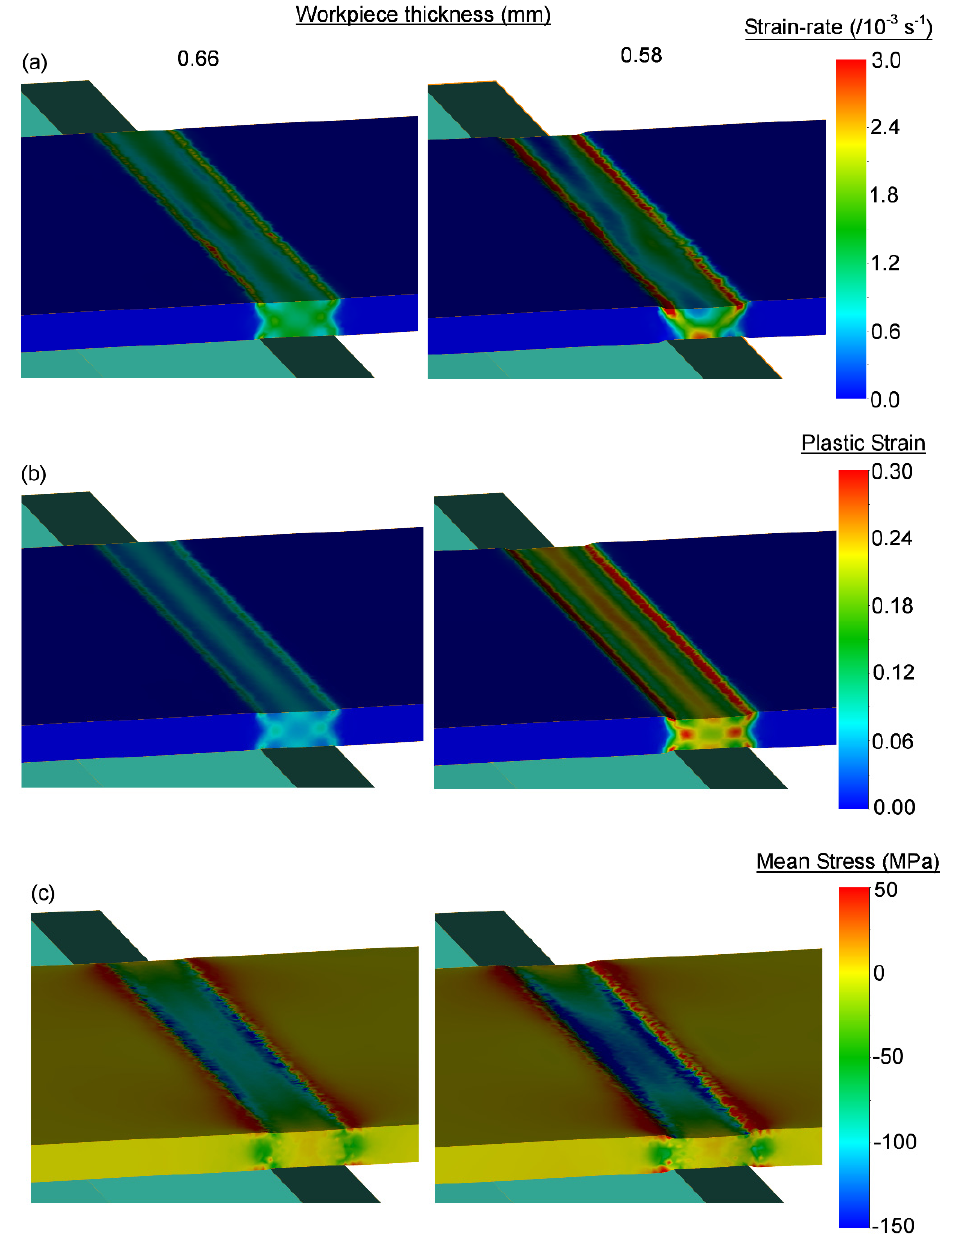
Figure 5. Distribution of ( a ) strain-rate, ( b ) plastic strain, and ( c ) mean stress at different stages of plane strain compression considering 3D conditions.